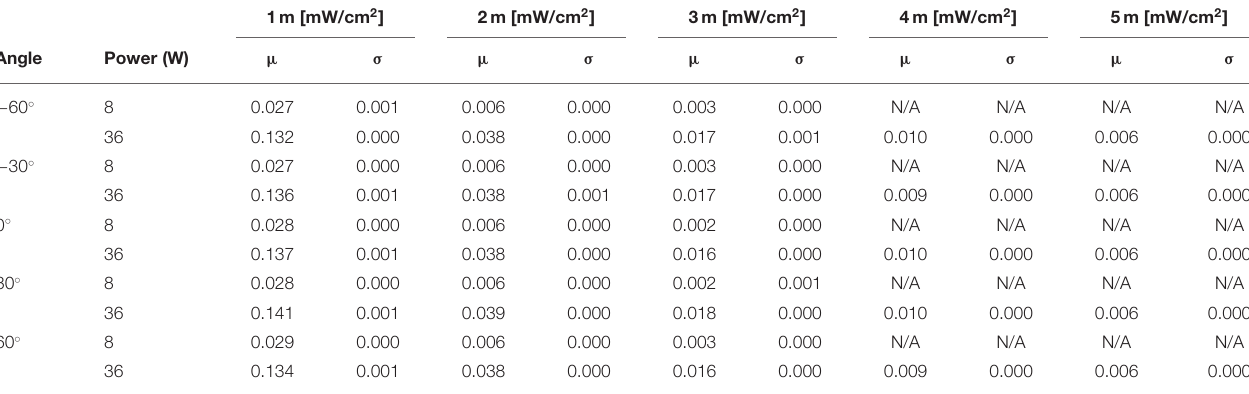
TABLE 2 | Instantaneous UV-C energy field around the robot for an 8W (model: Philips TUV 8W FAM/10X25BOX) and 36W lamps (model: Philips TUV 36W SLV). 1m [mW/cm 2 ] 2m [mW/cm 2